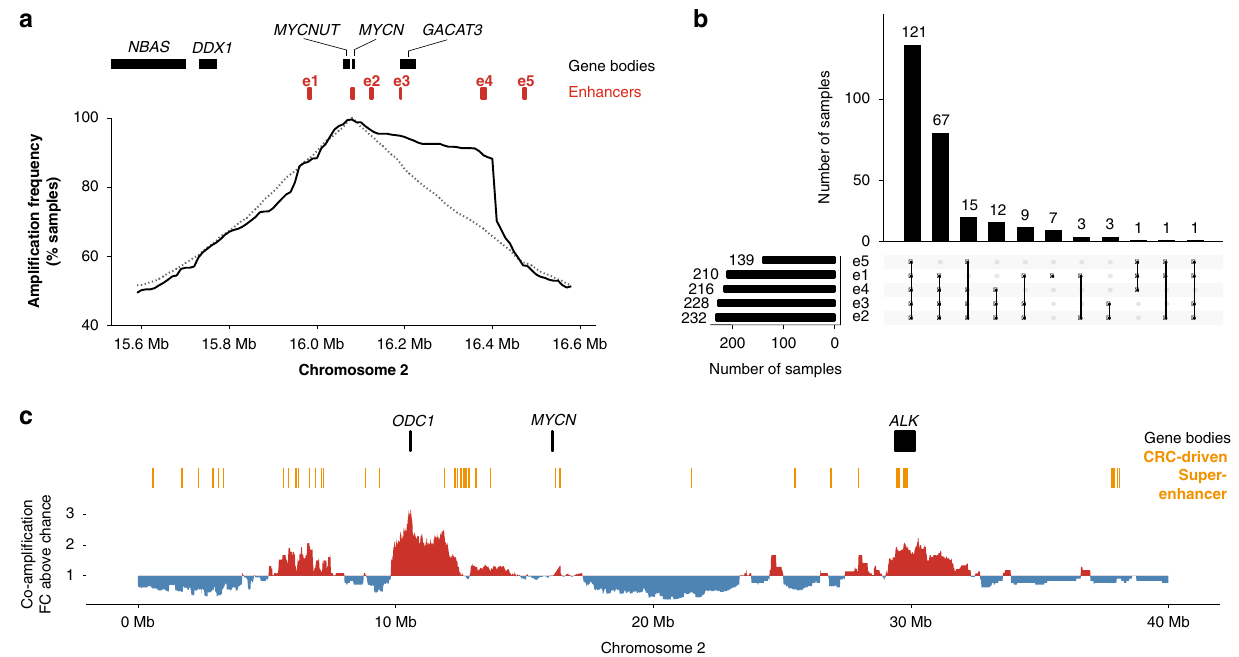
Fig. 2 Local enhancer e4 is signi fi cantly co-ampli fi ed with MYCN . a Co-ampli fi cation frequency of the immediate MYCN neighborhood measured using copy-number pro fi les from 240 MYCN -ampli fi ed neuroblastomas (solid line) compared to the expected co-ampli fi cation frequencies for randomized MYCN -containing amplicons (dashed line). b Upset plot showing the co-ampli fi cation patterns of all fi ve MYCN -speci fi c local enhancers identi fi ed in neuroblastoma. c Enrichment for co-ampli fi cation with MYCN of genomic regions on 2p (red, co-ampli fi cation more frequent than expected by chance; blue, co-ampli fi cation less frequent than expected by chance). Source data are provided as a Source Data fi